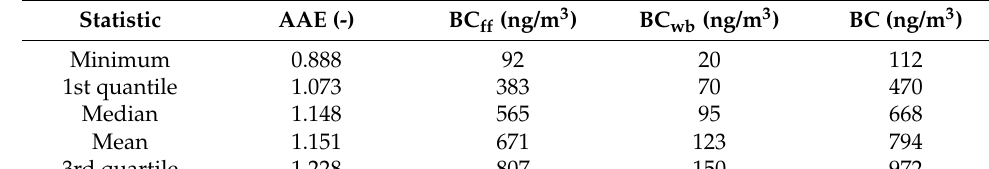
Table A1. Statistical summary of daily average campaign results.